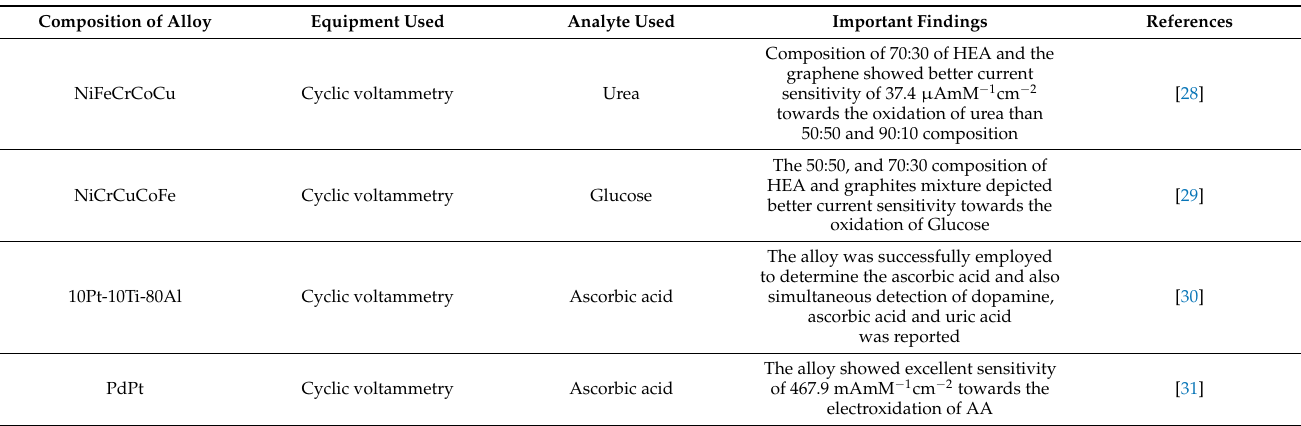
Table 2. Comparison of our results with the different types of alloy modified electrodes, as reported by various